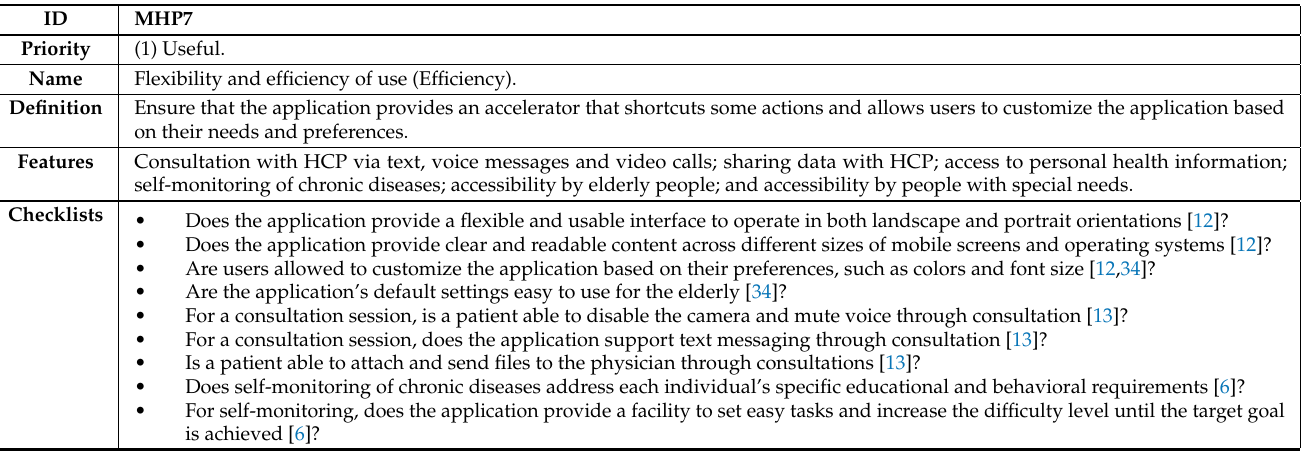
Table A7. Descriptive details of the seventh